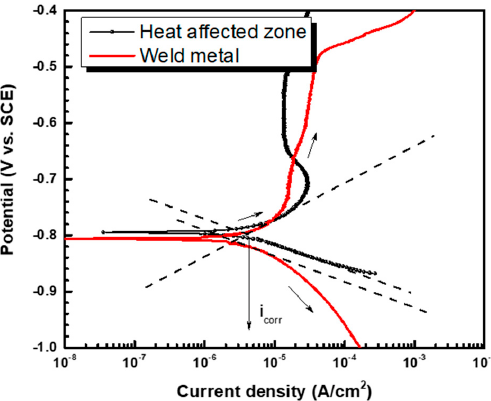
Figure 4. Polarization curves of the heat-affected zone and the weld metal of pipeline steel in the synthetic DH water. Table 3. Experimental conditions and calculated variables.